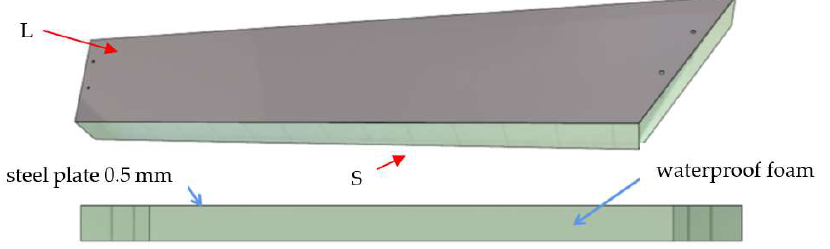
Figure 2. Schematic diagram of model.